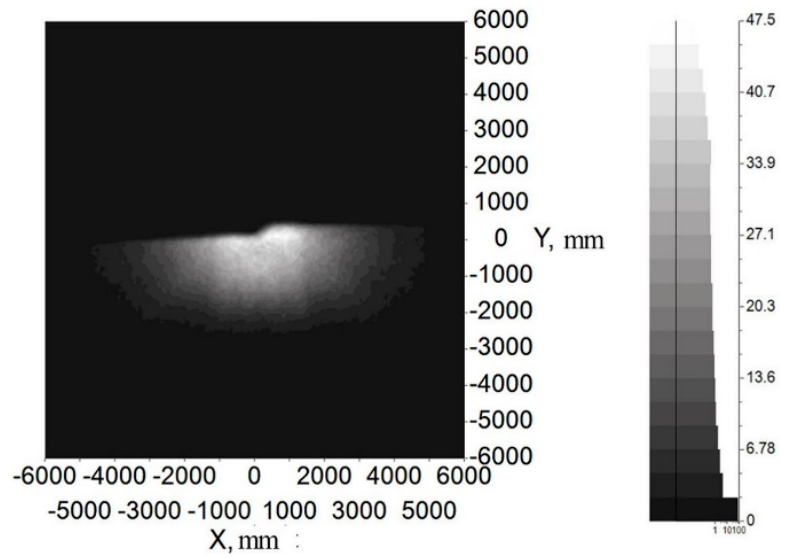
Figure 14. The illumination distribution of low beam.